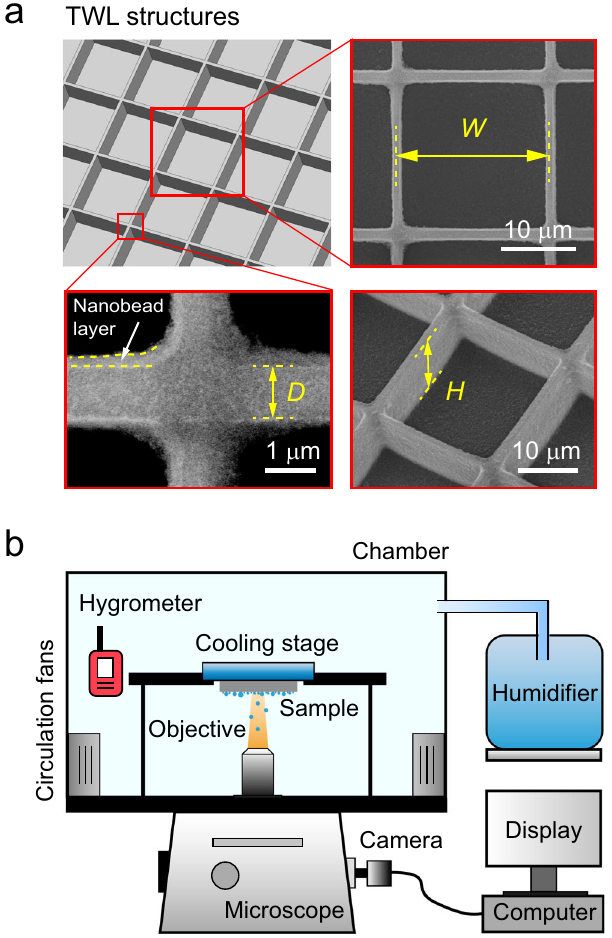
Fig. 1 | Surface characterization and experimental setup. a Illustration and scanning electronic micrograph (JSM-IT300, JEOL Japan) of the TWL structures. Widthofasinglelatticeis W =20 μ m.Thewalloflatticeshasathicknessof D =1 μ m, andaheightof H =10 μ m.An~250-nm-thicksuperhydrophobicnanobeadlayerwas prepared on the structures. The walls with coating are about 1.5 μ m in thickness. b Illustration of the experiments. Aninverted microscope was used to observe the breath fi gures on samples. Humidity and temperature of air during condensation were well controlled using a chamber. Saturated air was generated by a humidi fi er and blown into the chamber. Circulation fans can generate a mild fl ow with